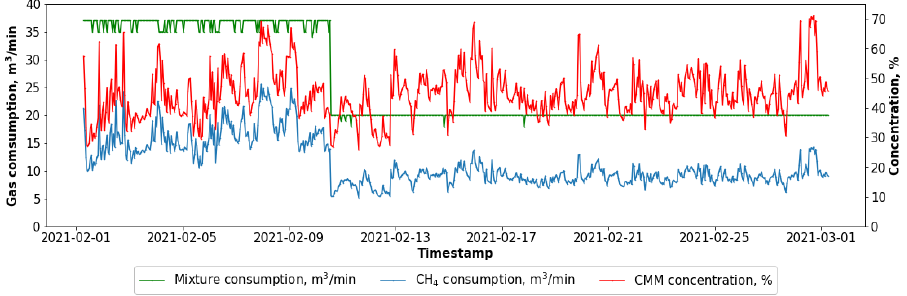
Figure 3. Monthly graph of changes in methane concentration and volumes of GAM removed from the